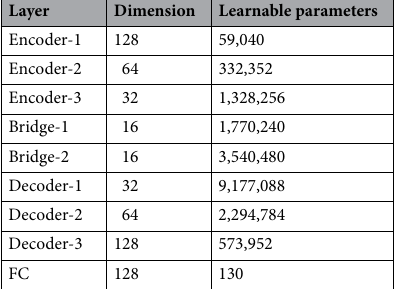
Table 4. The number of learnable parameters in the each layer of a U-Net